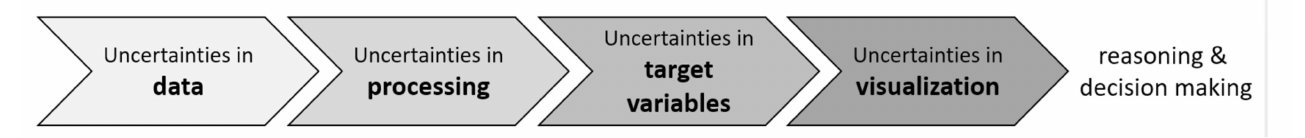
Figure 2. Chain of